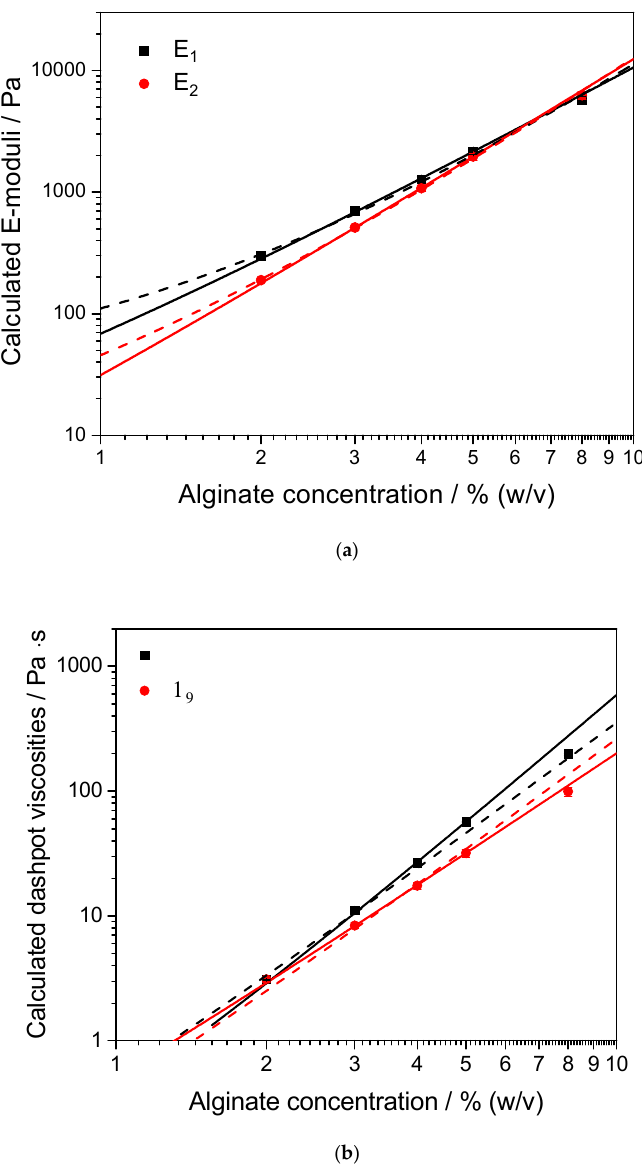
Figure 6. Resulting E-moduli ( a ) and Dashpot viscosities ( b ) for the Burgers model. Solid lines represent the power law like fit according to [51], dashed lines are fitted with a fixed scaling exponent of n = m = 3.